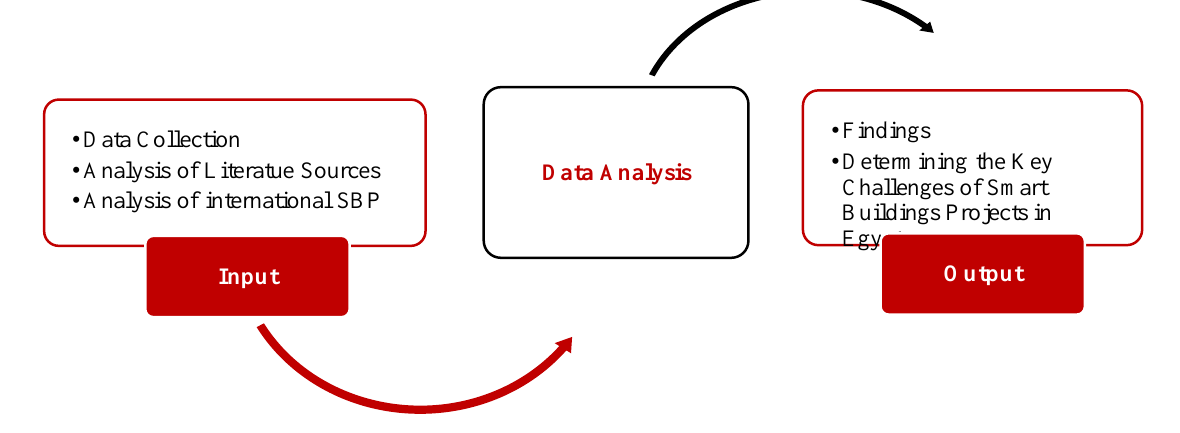
Figure 1. Flow of Research Methods; Source: